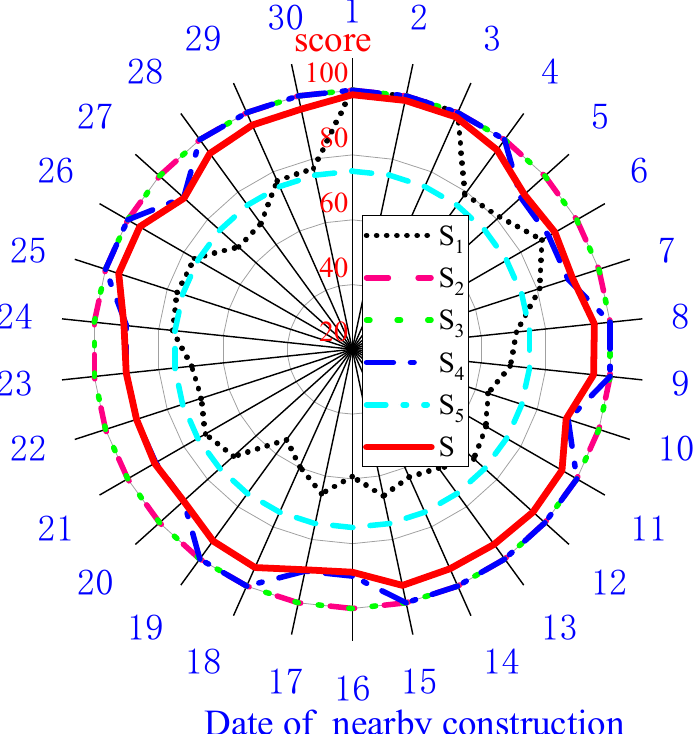
Figure 11. Assessment results during the nearby construction.